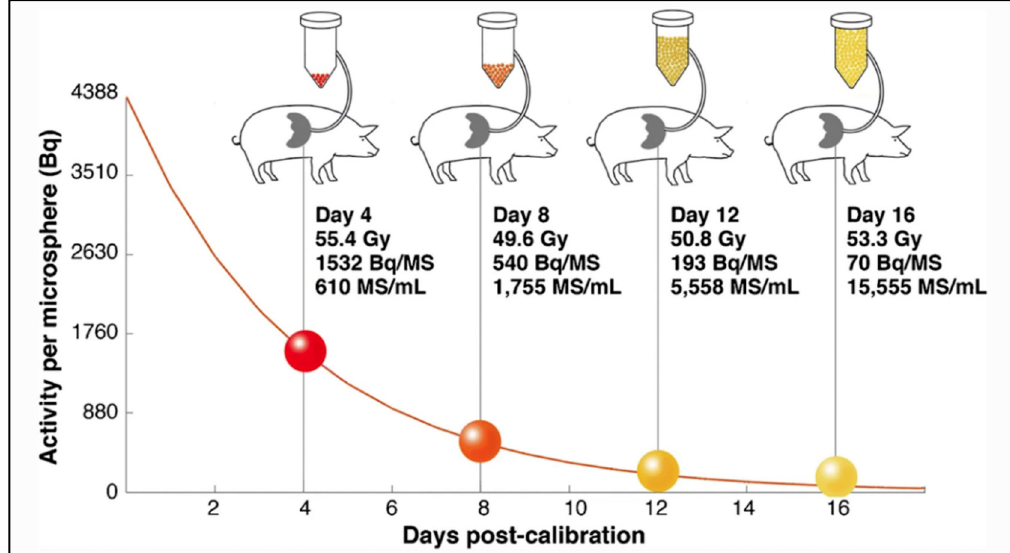
Figure 2. Amount of glass microspheres injected in pig livers as a function of time from microsphere calibration (4, 8, 12 or 16 days), resulting in spheres of different specific activity and concentrations. Reprinted from European journal of nuclear medicine and molecular imaging with permission of Springer Nature ( Eur. J. Nucl. Med. Mol. Imaging 2020, 47, 816–827).